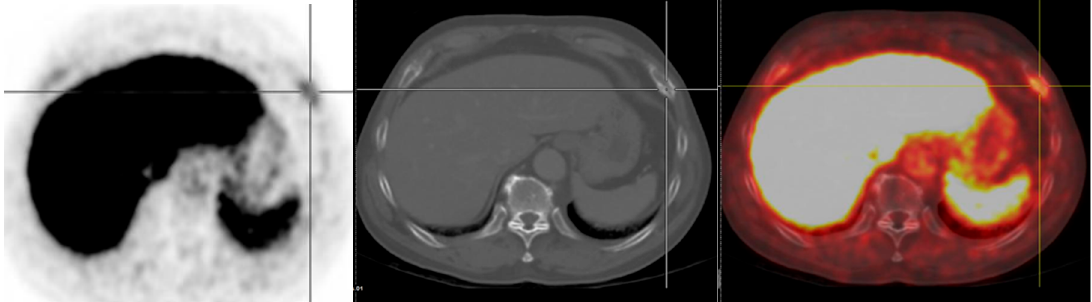
Figure 3. An example of old rib fracture in a PCa patient who underwent radical prostatectomy and RT, developed rising serum PSA with a level of 0.375 ng/mL (nadir 0.1 ng/mL) was sent to evaluate BCR. 18 F PSMA PET scan revealed faint uptake at lateral aspect of left 7th rib associated with subtle sclerotic lesion (SUVmax of 3.14).